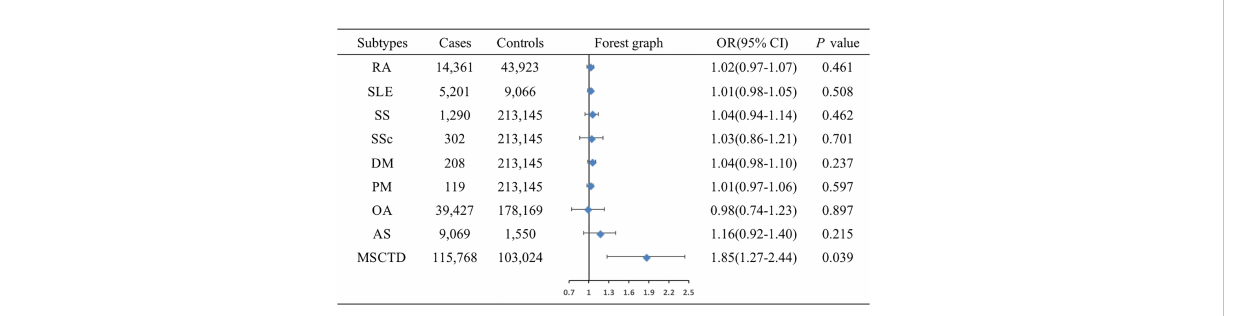
FIGURE 4 Associations of genetic liability to MSCTD with risk of ER- BC in the European individuals. AS, ankylosing spondylitis; BC, breast cancer; CI, con fi dence interval; ER, estrogen receptor, DM, dermatomyositis; MSCTD, diseases of the musculoskeletal system and connective tissue; OA, osteoarthritis; OR, odds ratio; PM, polymyositis; RA, rheumatoid arthritis; SLE, systemic lupus erythematosus; SSc, systemic sclerosis; SS, Sjogren syndrome.